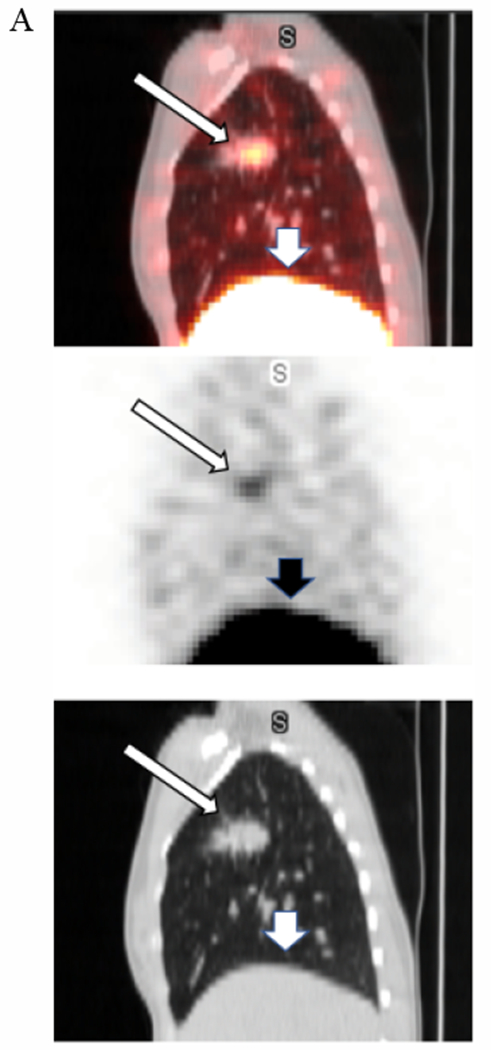
False positive.A 35-year-old female with NSCLC enrolled onto our study as HER2(−) based on pericardial effusion biopsy (HER2 2+; FISH ratio 1.22). The right upper lung lesion (the Target Lesion) is easily visualized (narrow arrows) on these fused SPECT/CT, SPECT, and low attenuation CT sagittal projections from the 71h post iv infusion of 128.4MBq[160.4ug] 111In-CHX-A”-DTPA trastuzumab imaging session. Tumor to Background Ratio is 6.7. The wider arrows show the liver.